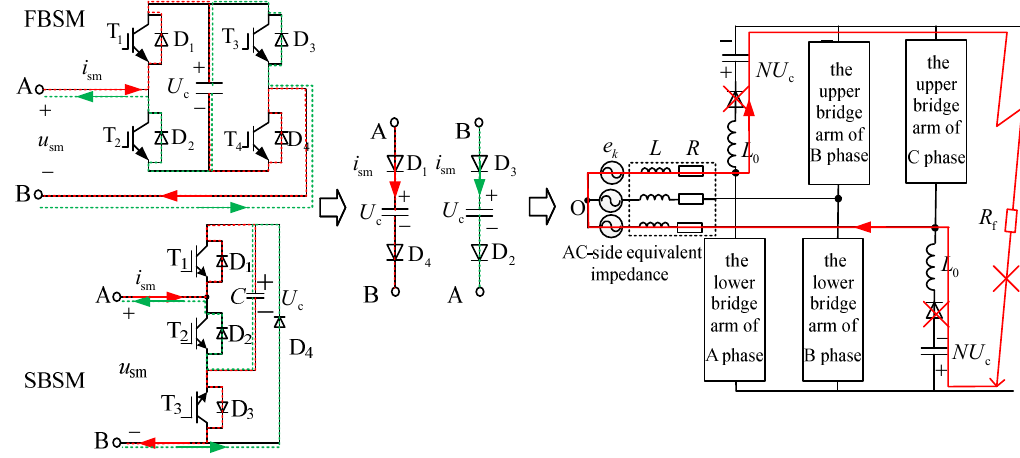
Figure 2. The uncontrolled circuit after blocking the converter.